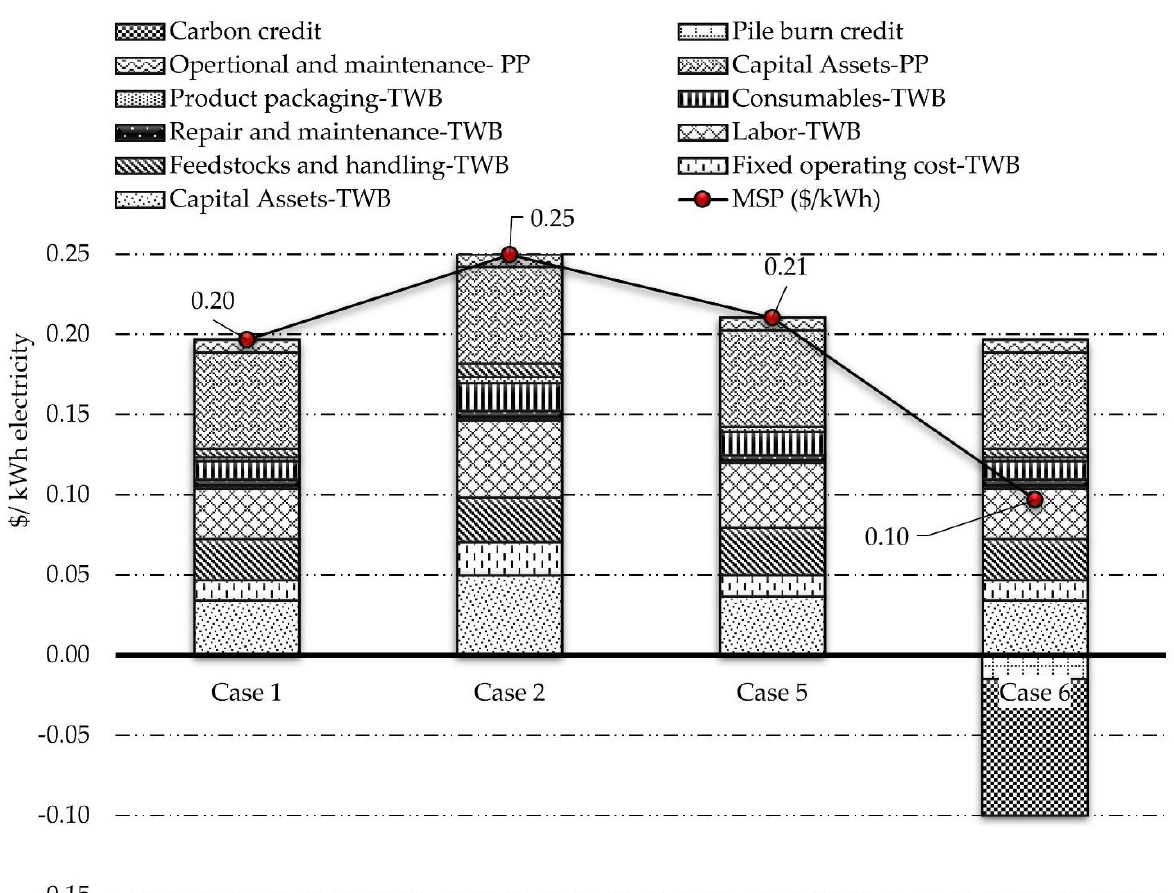
Figure 8. Comparison of minimum selling price (MSP) per 1 kWh electricity generated using torrefied wood briquettes (TWBs) in power plant (PP), and contributions of various costs inputs to MSP (only for electricity values).